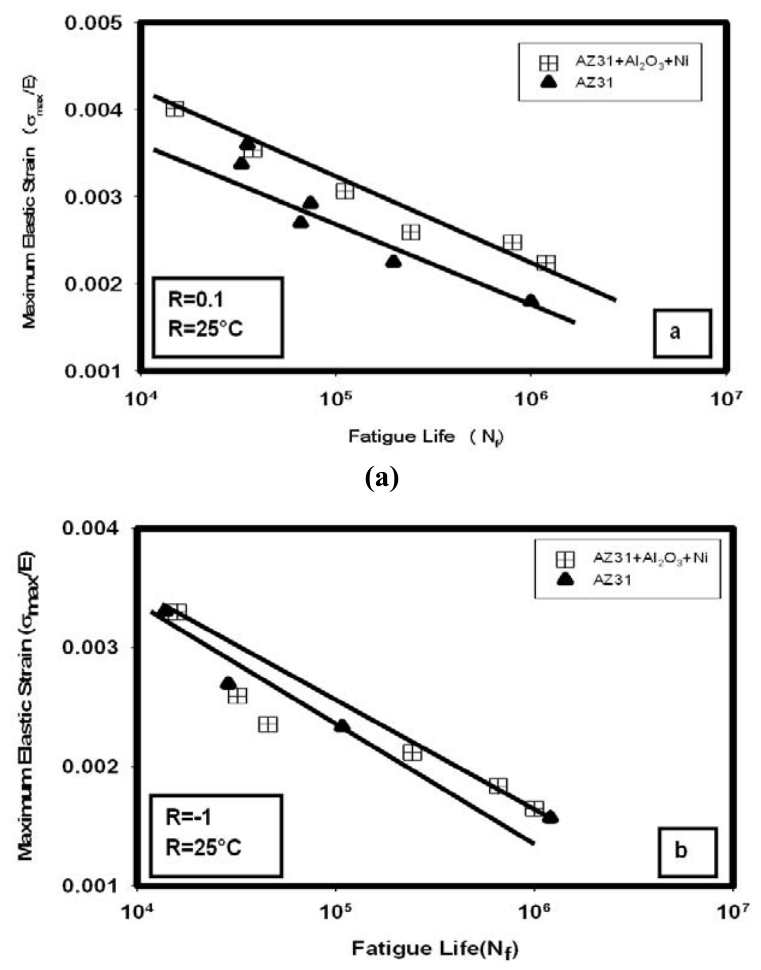
Figure 4. Comparison of the variation of maximum elastic strain [maximum stress to ) of the dual particle reinforced magnesium modulus of elasticity (E)] with fatigue life (N f alloy (AZ31 + Al O + Ni) with the unreinforced matrix alloy (AZ31) cyclically deformed 2 3 at room temperature (T = 25 °C) at: ( a ) Load ratio of 0.1; ( b ) Load ratio of −